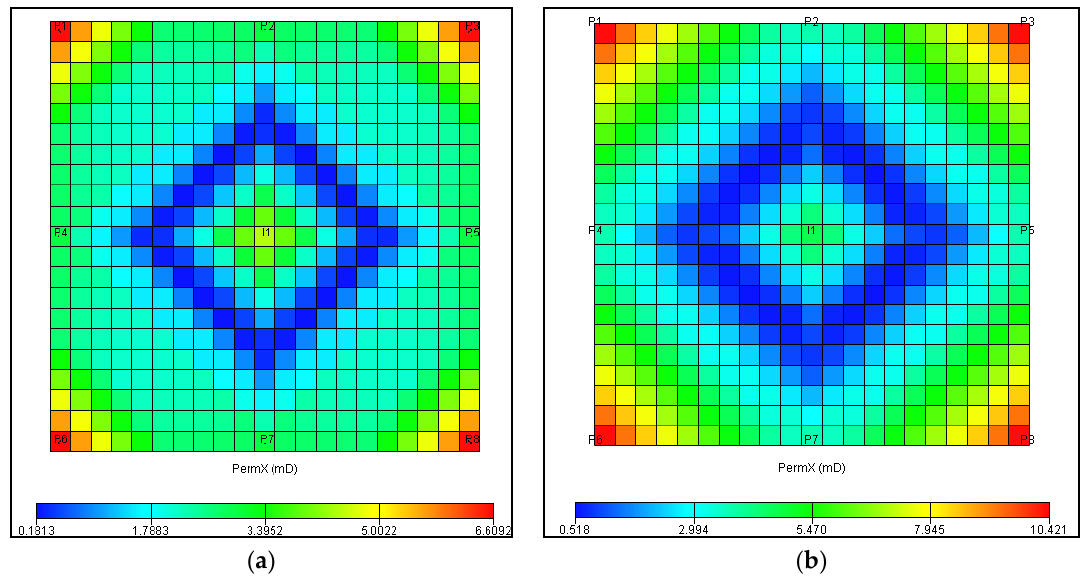
Figure 13. Permeability distribution diagram under non-Darcy flow: ( a ) January and ( b ) March.